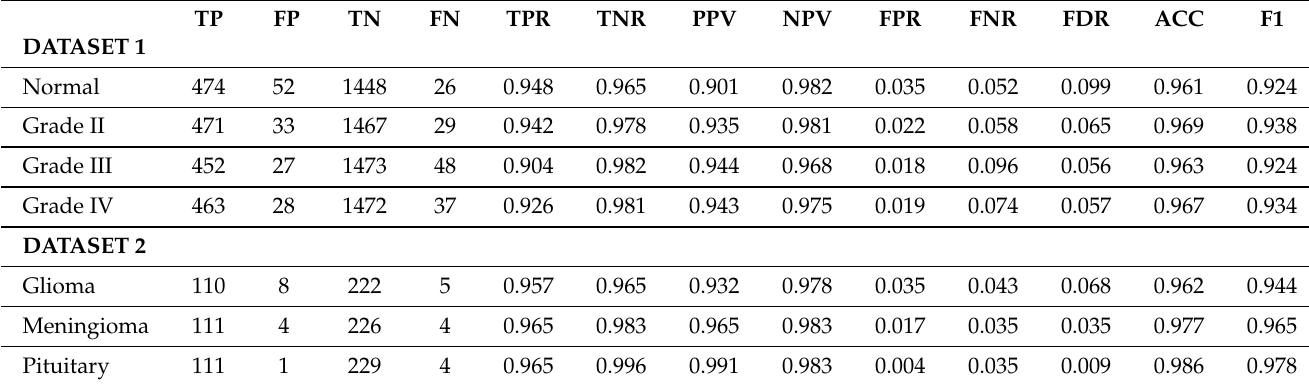
Table 11. MRI brain tumor classification performance metrics for CNN + mFA approach